Question: Generate an informative caption for the figure above.
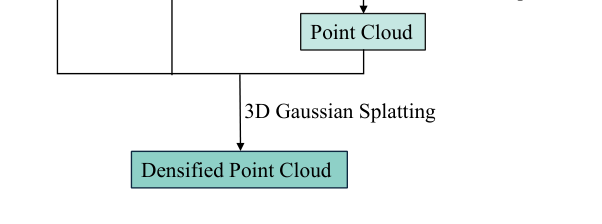
Answer: Flowchart of HoloGS: Via the HoloLens 2 sensor streaming, the required data is directly extracted and processed during data capturing. From the depth data, a point cloud is in- stant created which, together with the RGB images and corres- ponding camera poses, is then fed into 3D Gaussian Splatting.